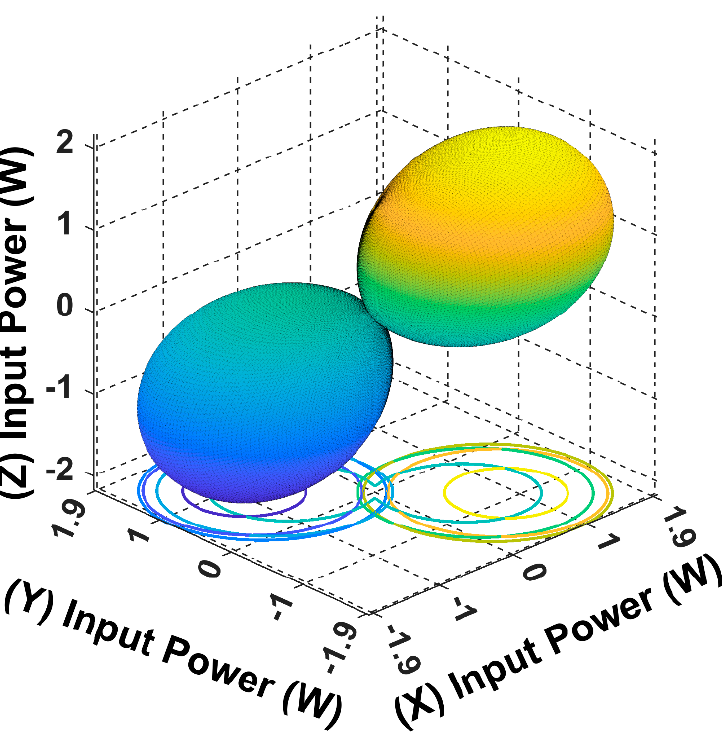
Figure 15. The input power spherical plot for the 3D WPT system when the receiver is placed at α = φ = 135°.